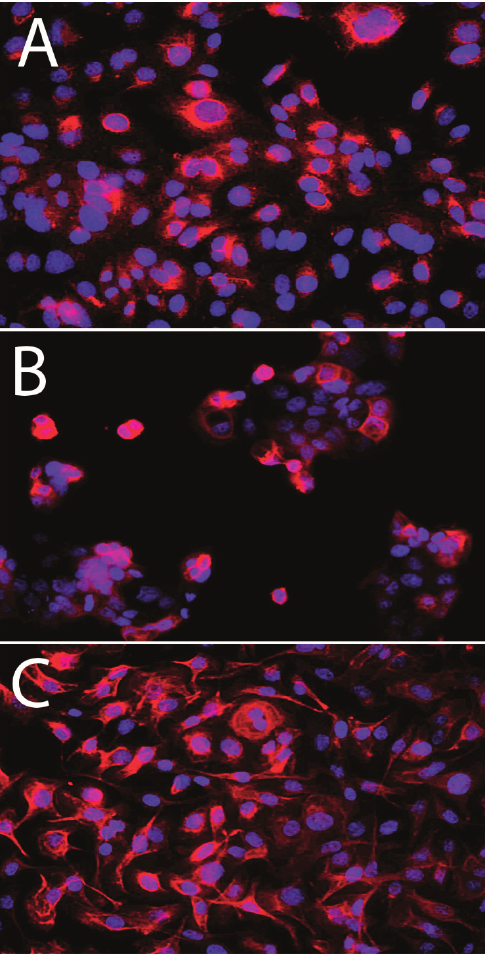
Figure 2. MT1 expression in membrane and cytoplasm of IOSE 364 ( A ); SK-OV-3 ( B ); OVCAR-3 ( C ) cell